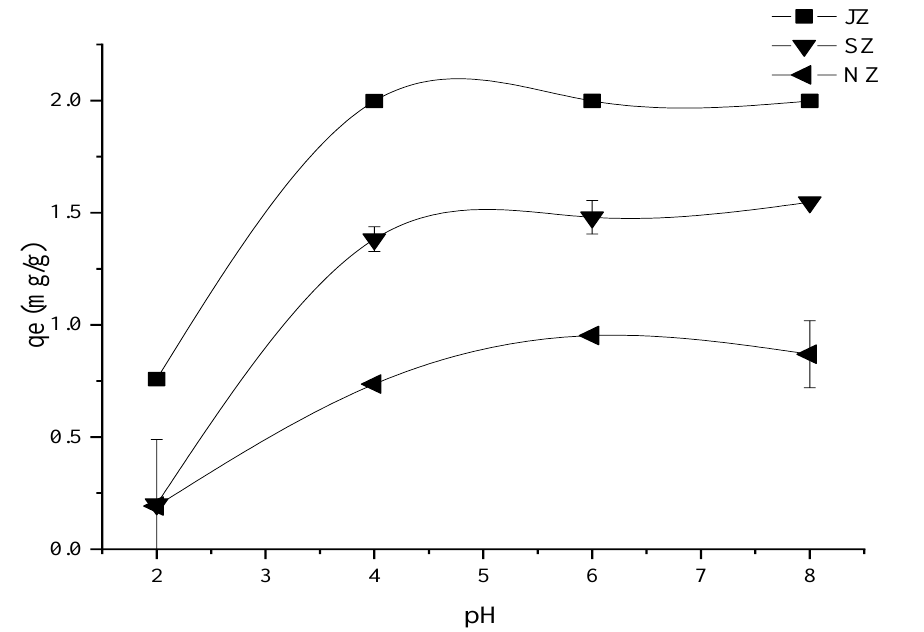
Figure 8. Effect of initial pH on Cd adsorption rate by different zeolites. The effect of different temperatures on the adsorption of Cd for different modified ze- olites varied (Figure 9). For JZ, when the initial concentration were 130, 160, and 190 mg/L, the adsorption capacity at 35 ◦ C was significantly higher than that at 15 ◦ C and 25 ◦ C, with an increase of 5.60, 8.14, and 7.64% with respect to that at 15 ◦ C and 5.43, 4.48, and 3.16% with respect to that at 25 ◦ C; when the initial concentrations were 160 and 190 mg/L, the adsorption capacity at 25 ◦ C was significantly higher than that at 15 ◦ C by 3.86 and 4.62%, respectively. For SZ, when the initial concentrations were 130, 160, and 190 mg/L, the adsorption capacity at 35 ◦ C was significantly higher than that at 15 ◦ C by 4.15, 7.70, and 6.58%, respectively; when the initial concentrations were 130 and 160 mg/L, the adsorption capacity at 35 ◦ C was significantly higher than that at 25 ◦ C by 2.60 and 3.05%, respectively; when the initial concentrations were 130 and 160 mg/L, the adsorption capacity at 25 ◦ C was significantly higher than at 15 ◦ C by 1.44, and 5.04%, respectively. For NZ, when the initial concentrations were 100, 160, and 190 mg/L, the adsorption capacity at 35 ◦ C was significantly higher than that at 15 ◦ C by 4.07, 3.93, and 4.02%, respectively. However, the equilibrium adsorption capacities of JZ were significantly higher than that of SZ and NZ at temperatures between 15 and 35 ◦ C and were increased by 7.98–8.95 and 28.49%–31.18%, respectively; meanwhile, the equilibrium adsorption capacities of SZ were significantly higher than that of NZ and were increased by 22.29, 23.29, and 24.42%,